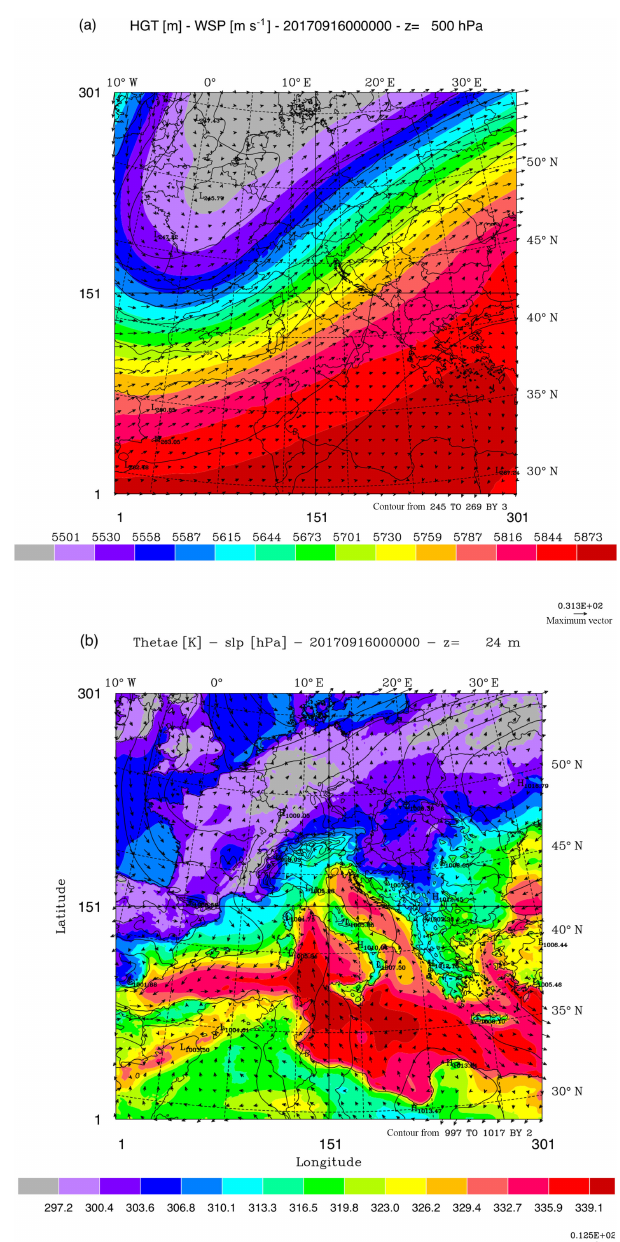
Figure 2. (a) Geopotential height (filled contours), temperature (contours), and wind vectors at 500hPa on 16 September 2017 at 00:00UTC. Maximum velocity is 31ms − 1 ; (b) equivalent poten- tial temperature (filled contours), sea-level pressure (contours), and wind vectors at 24m above the surface (maximum value 13ms − 1 ). A low-pressure pattern forms over northern Italy, with a front in the western